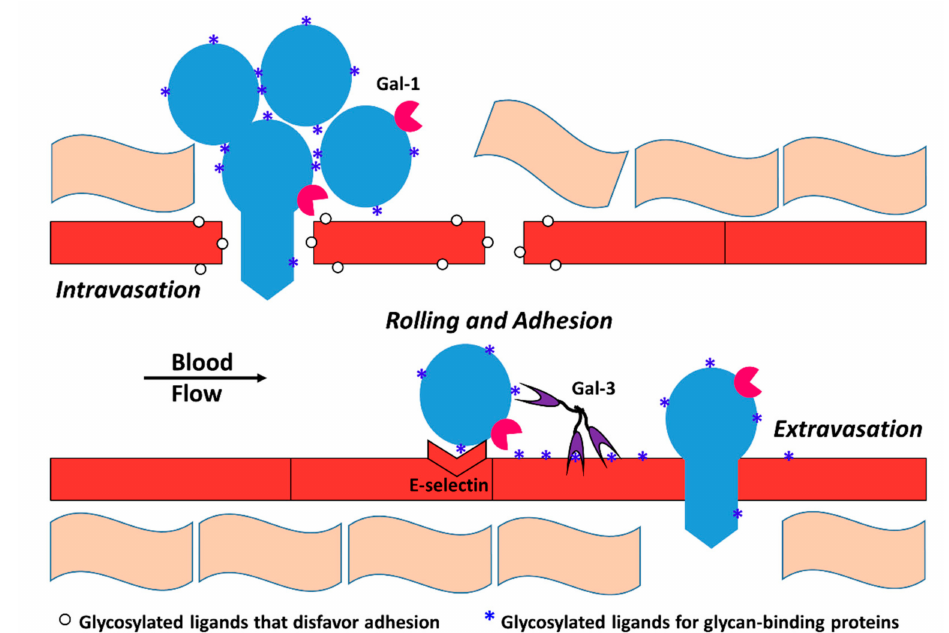
Figure 3. Glycan-mediated intravasation, rolling, and extravasation. Glycan modifications on endothelial cells (red) alter endothelial adhesion and may contribute to endothelial permeability and tumor cells (blue) intravasation. Circulating lectins such as Gal-3 and endothelial lectins including E-selectin initiate rolling, adhesion, and extravasation of tumor cells to the endothelium, frequently at distant sites. Integrins also assist in this